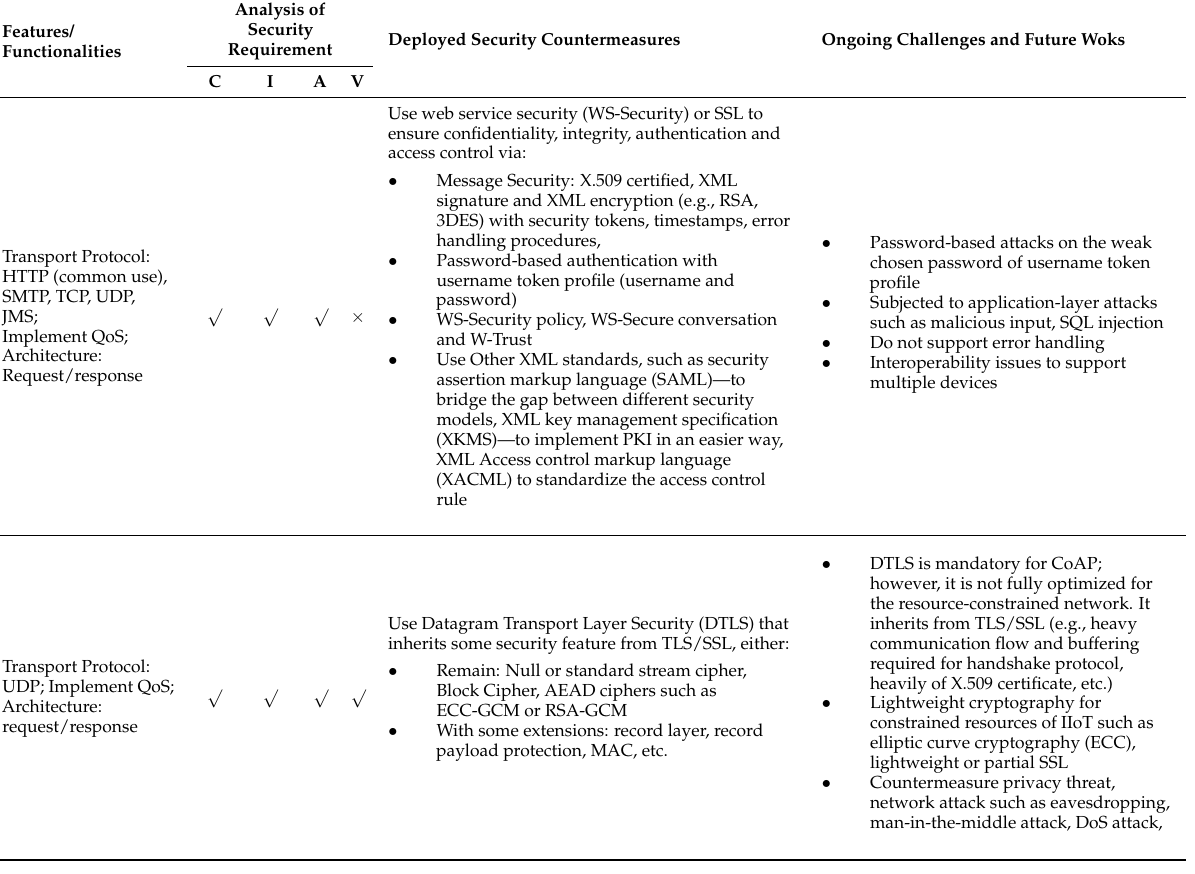
Table 10. Security analysis on application